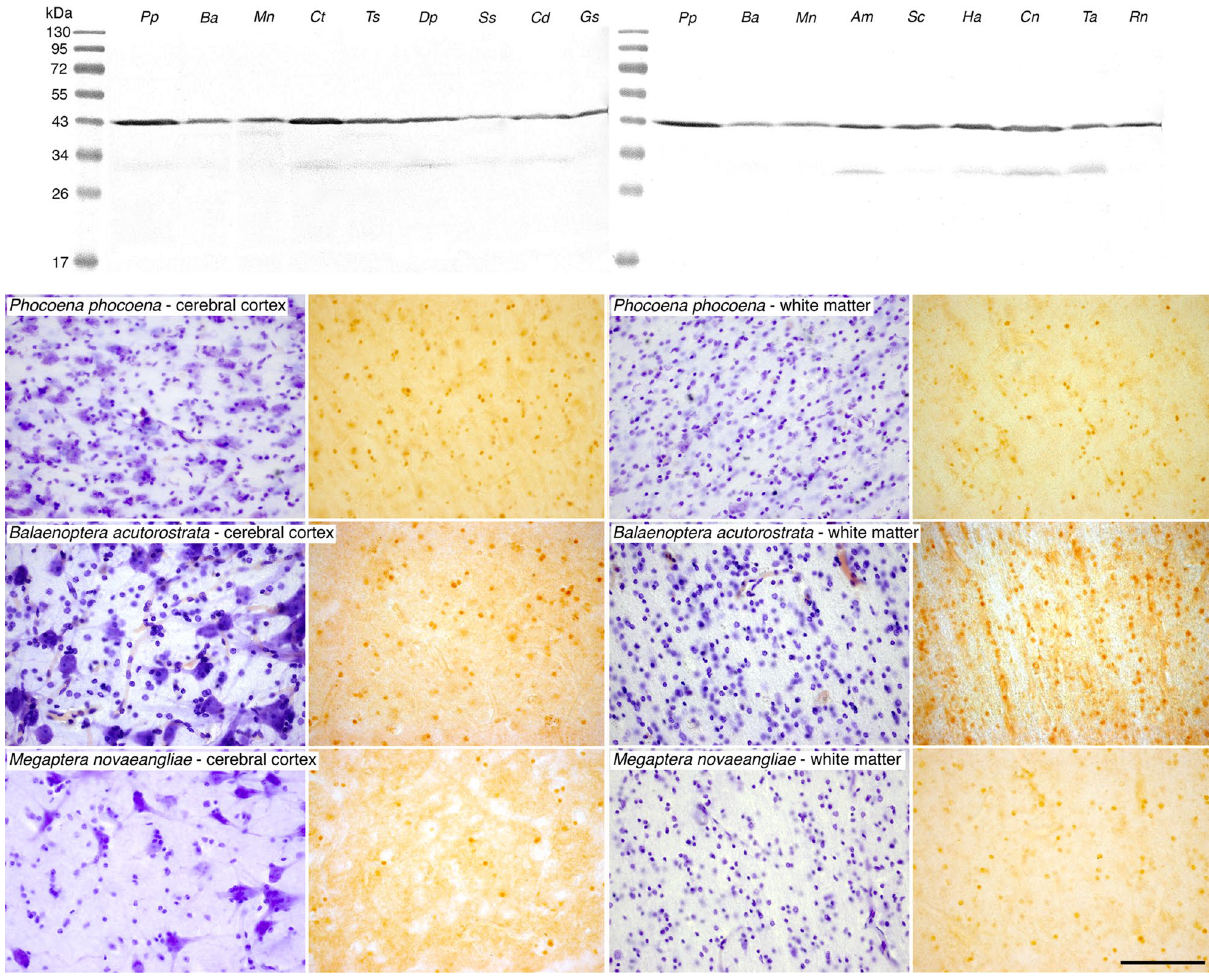
Figure 4. UCP4 Western blotting and immunostaining in cetartiodactyl cerebral cortex. While UCP4 was present in the cortical grey and white matter of all species, as evidenced in the Western blot at the top of the panel from the occipital cortex of all species studied, it was only found to be immunolocalized to glial cells in the cetaceans (See Figure S6 for full-length unedited Western immunoblots). Photomicrographs of Nissl-stained (purple colored images) and UCP4-immunostained (brown colored images) from cortical and subcortical white matter sections in a range of cetacean species. Note the presence of UCP4-immunoreactivity in approximately 30% of glial cells in the cerebral cortex and approximately 60% of glial cells in the white matter in all cetacean species (Table 1). The scale bar in the UCP4-immunostained section of Megaptera novaeangliae —white matter, equals 100 µm and applies to all photomicrographs. Pp —harbor porpoise, Phocoena phocoena ; Ba —minke whale, Balaenoptera acutorostrata ; Mn —humpback whale, Megaptera novaeangliae ; Ct —blue wildebeest, Connochaetes taurinus ; Ts —greater kudu, Tragelaphus strepsiceros ; Dp —blesbok, Damaliscus pygargus ; Ss — domestic pig, Sus scrofa ; Cd —dromedary camel, Camelus dromedarius ; Gm —sand gazelle, Gazella marica